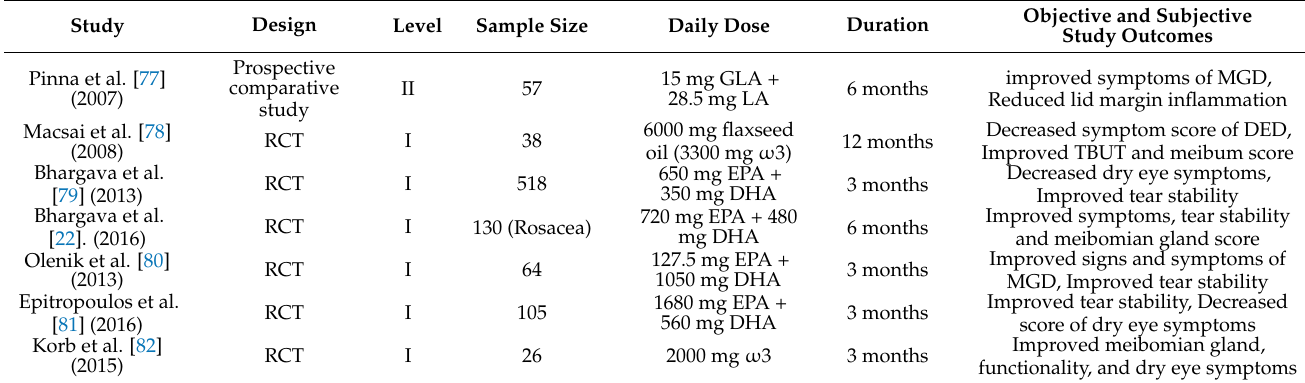
Table 4. Summary of the studies on the efficacy of ω 3 PUFAs on